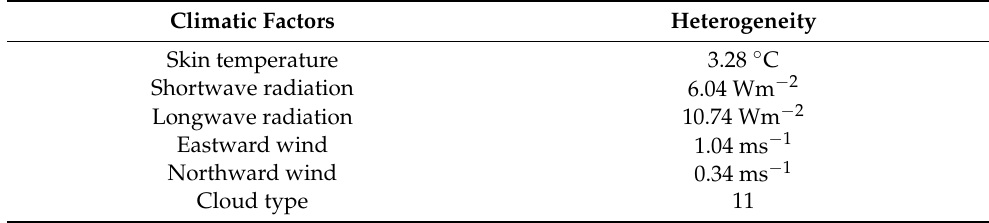
Table 2. Heterogeneity of the climatic factors in Dome